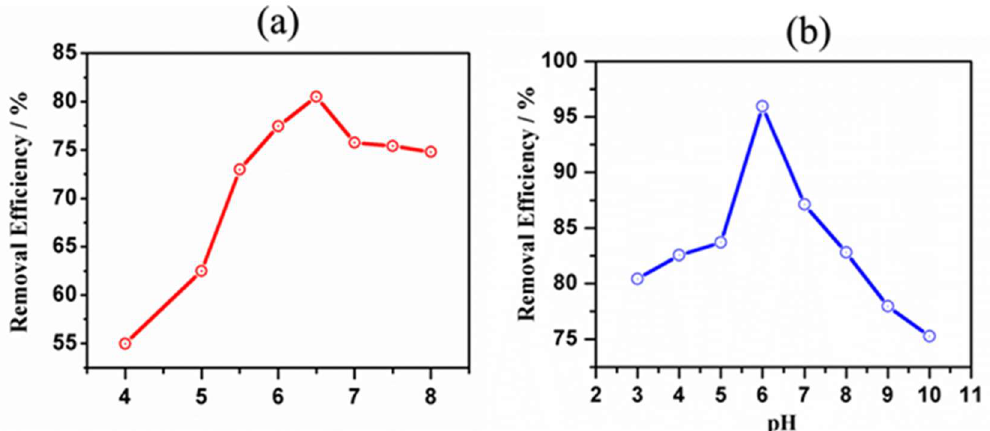
Figure 8. The pH dependency of the removal efficiency (RE%) of ( a ) Ni 2+ and ( b ) Cd 2+ ions by hematite nanoparticles.